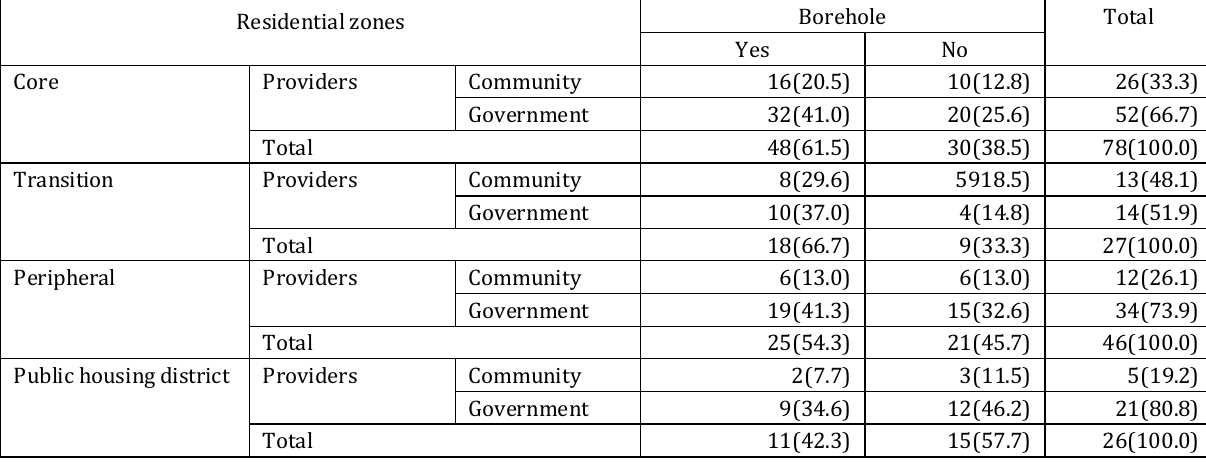
Table 3. Providers of Boreholes across residential zones